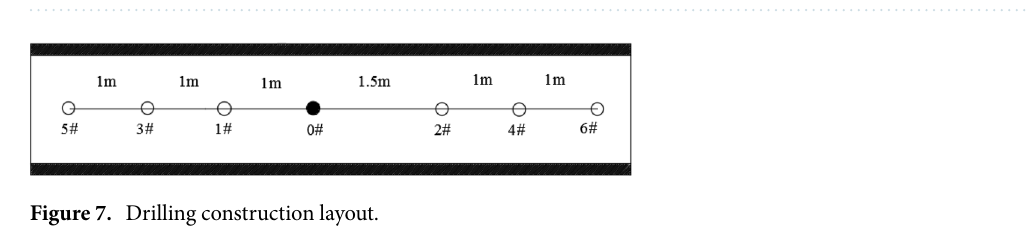
Figure 6. Damage evolution cloud map of coal with a control hole.